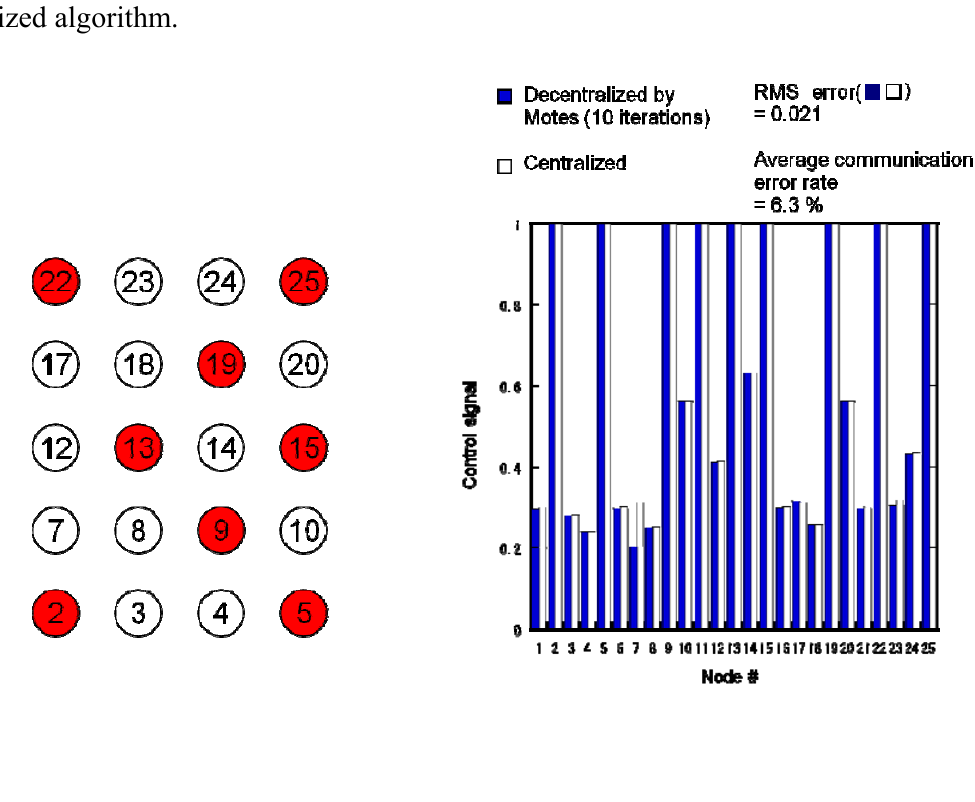
Figure 12. Occupancy pattern and experimental distributed actuation results obtained using Motes implemented with proposed decentralized algorithm and simulation of centralized